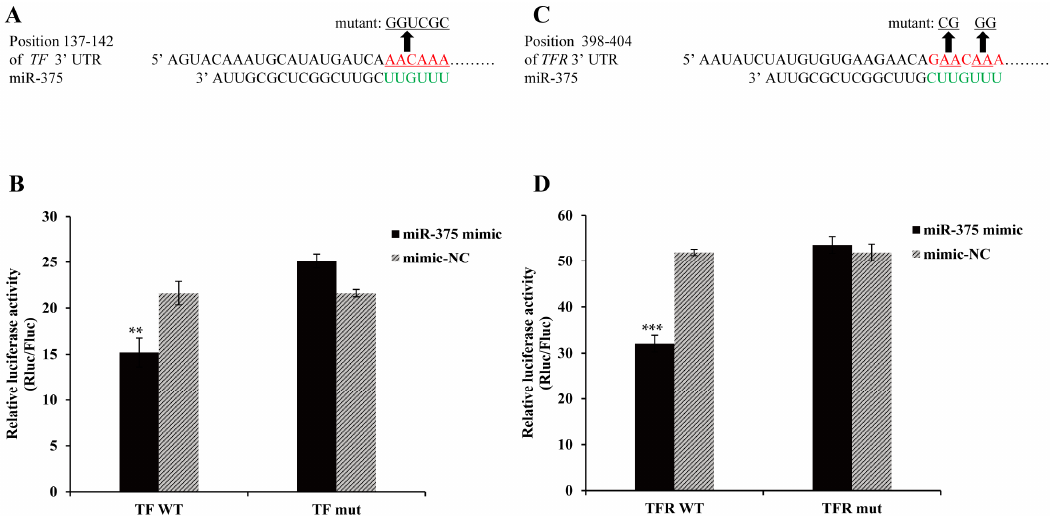
Figure 9. miR-375 directly targets the 3’ UTR of TF and TFR genes. ( A , C ) miR-375 seed sequence and its complementary sequences on 3’ UTR are shown in red and green, respectively. Mutant sites are indicated by arrows and underlined; ( B , D ) miR-375 mimic or mimic-NC were co-transfected with TF or TFR 3’ UTR or mutant dual-luciferase reporters into HeLa cells. Renilla luciferase activities were detected and normalized to firefly luciferase. Values were described as mean ± SD ( n = 3, ** p < 0.01, *** p < 0.001).